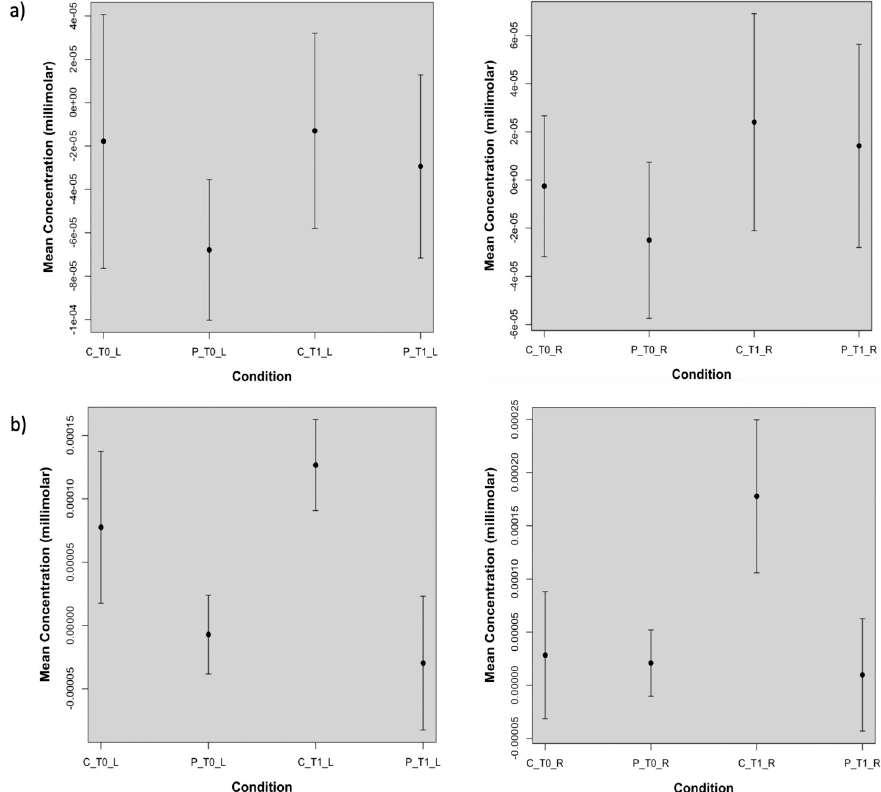
Figure 6. Plots of the oxyhemoglobin concentrations obtained from: ( a ) the real stimulation and averaged over the channels corresponding to the stimulated side and not stimulated side. On the left hemisphere, indicated with _L, real TDCS increased significantly ( p -value lower than 0.05) oxyhemoglobin levels in patients (P), but not in controls. On the right hemisphere (_R) there was a significant oxyhemoglobin increase in controls (C) and in patients with p -values lower than 0.05 and 0.001, respectively. In ( b ) the sham effect is shown. On the stimulated and not stimulated hemisphere, the sham session determined an oxyhemoglobin increase in controls which is significant for the not stimulated side, leaving the oxy-hemoglobin levels in patients unchanged at T1.